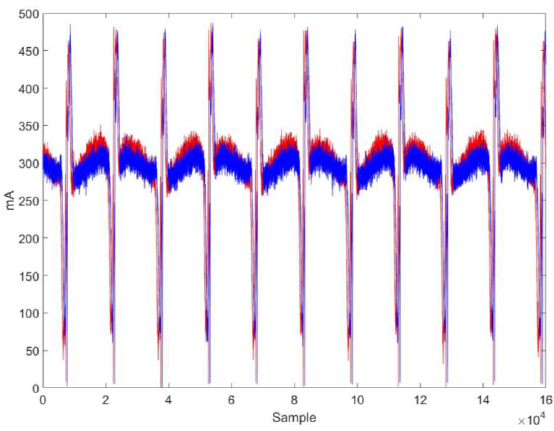
Figure 3. Motor current plot of the 4% ball-screw preload without pretension and with a 20-kg payload under a repetitive motion speed of 600 rpm for 60 min. The blue and red colors indicate the conditions with and without oil-cooling circulation,